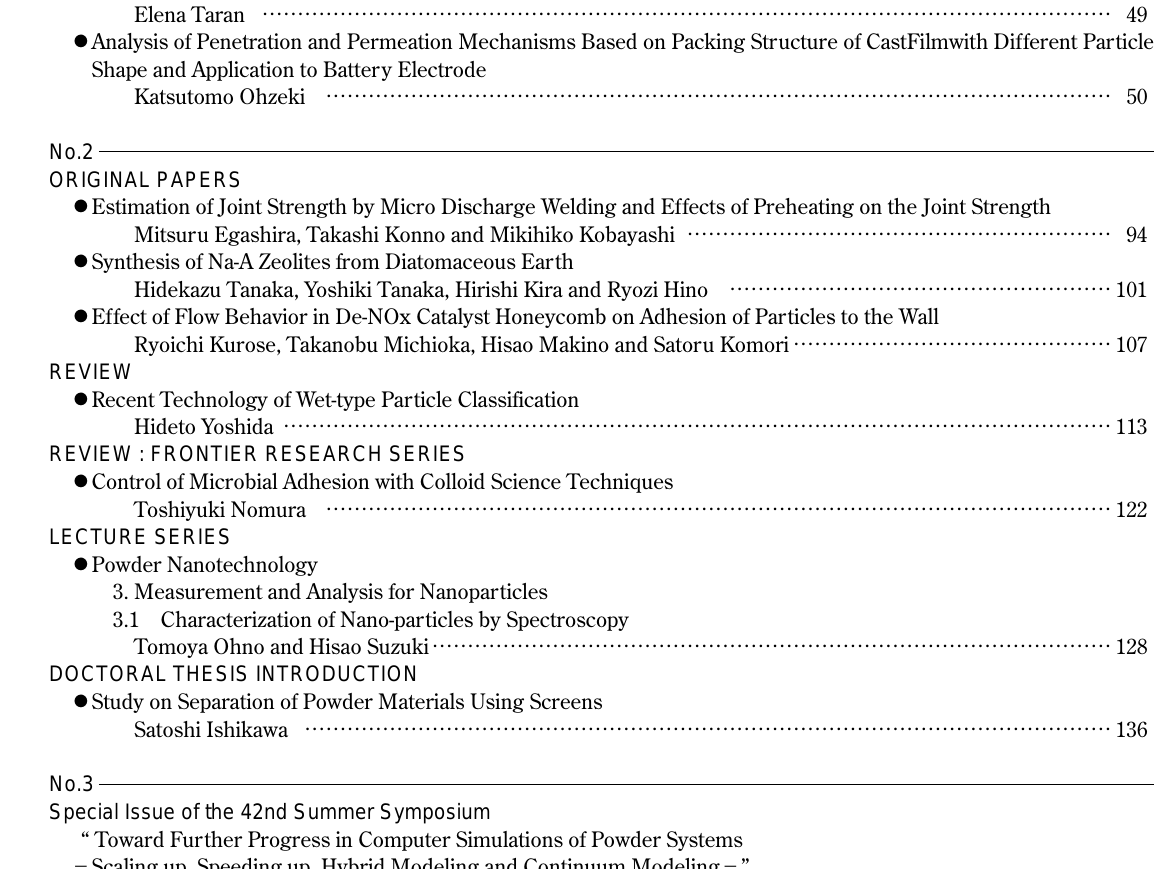
・ Molecular-Scale Friction Characteristics of Silica Surfaces in High pH Solution Studied by Atomic Force Microscopy ・ Analysis of Penetration and Permeation Mechanisms Based on Packing Structure of CastFilmwith Different Particle Shape and Application to Battery Electrode